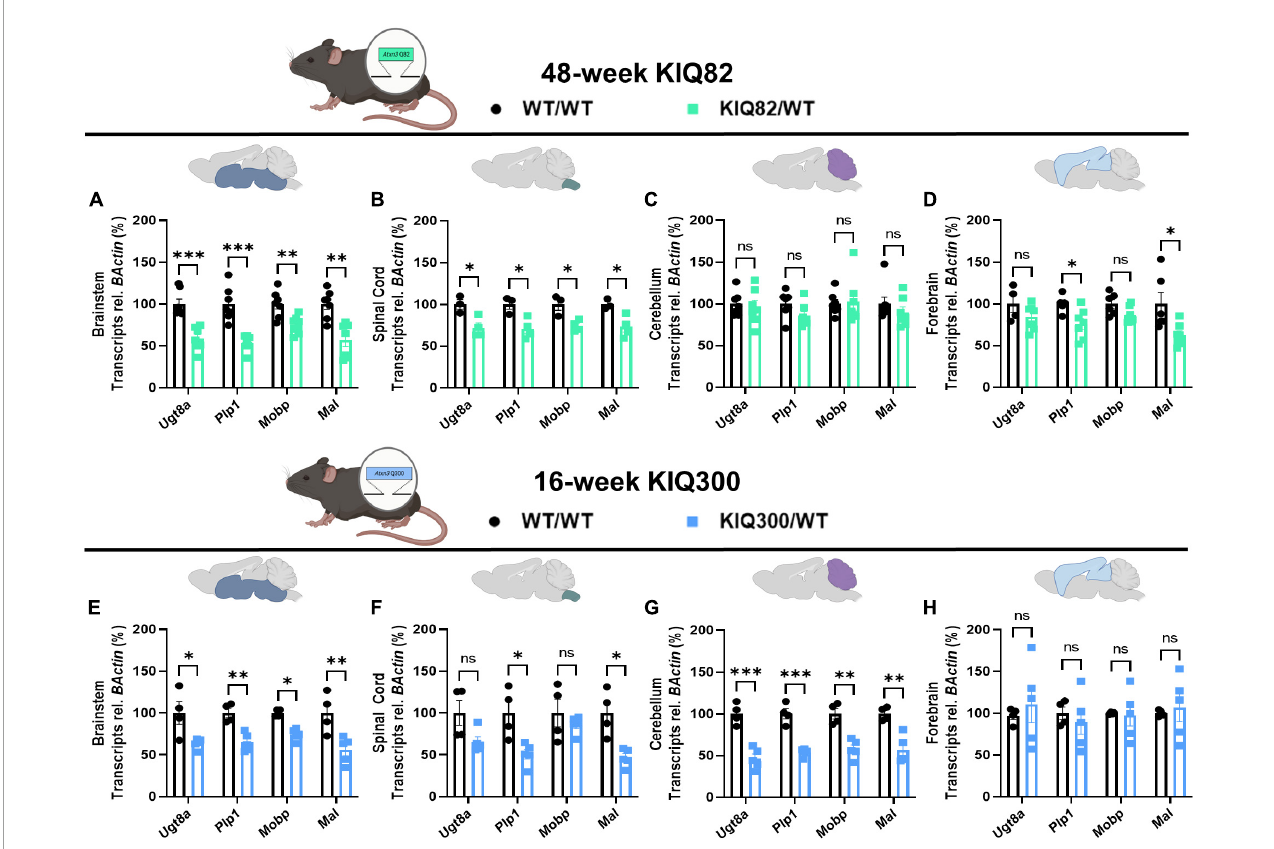
FIGURE2 Regional oligodendrocyte transcriptional dysregulation is observed in the Knock-In SCA3 mouse models. QPCR analysis of oligodendrocyte maturation markers in 48-week hemizygous (Q82/WT) KIQ82 mice relative to WT/WT in panel (A) brainstem, (B) spinal cord, (C) cerebellum, and (D) forebrain. QPCR analysis of oligodendrocyte maturation markers in 16-week hemizygous (Q300/WT) KIQ300 mice relative to WT/WT in panel (E) brainstem, (F) spinal cord, (G) cerebellum, and (H) forebrain. Each data point represents an independent mouse per genotype. Unpaired Student’s t -tests or Mann–Whitney tests were performed, depending on normality distribution as determined by Shapiro–Wilk tests: ∗ p < 0.05, ∗∗ p < 0.01, ∗∗∗ p < 0.001, ns, not